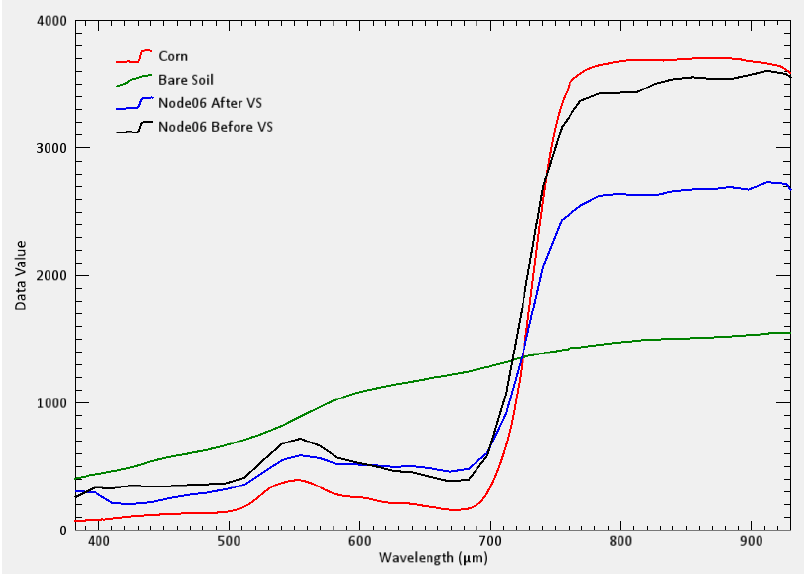
Figure 7. Comparison between measured corn and bare soil spectra and the spectra at the location of the specified sensor node from hyperspectral images before and after vegetation suppression.